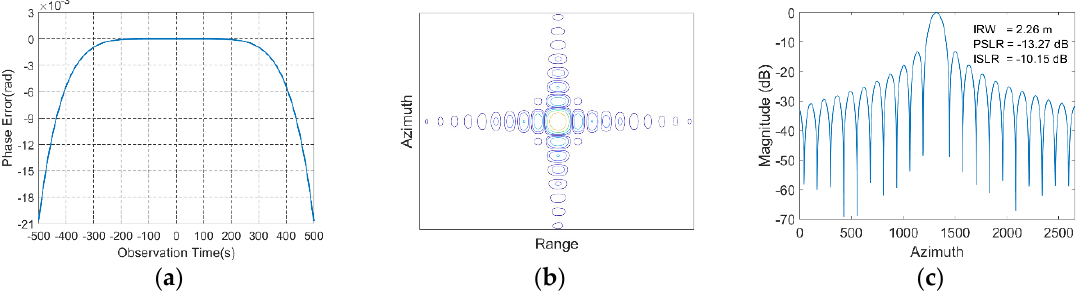
Figure 15. The fitting error and focusing result of the fourth-order Taylor expansion at perigee. ( a ) Fitting error; ( b ) 2-D